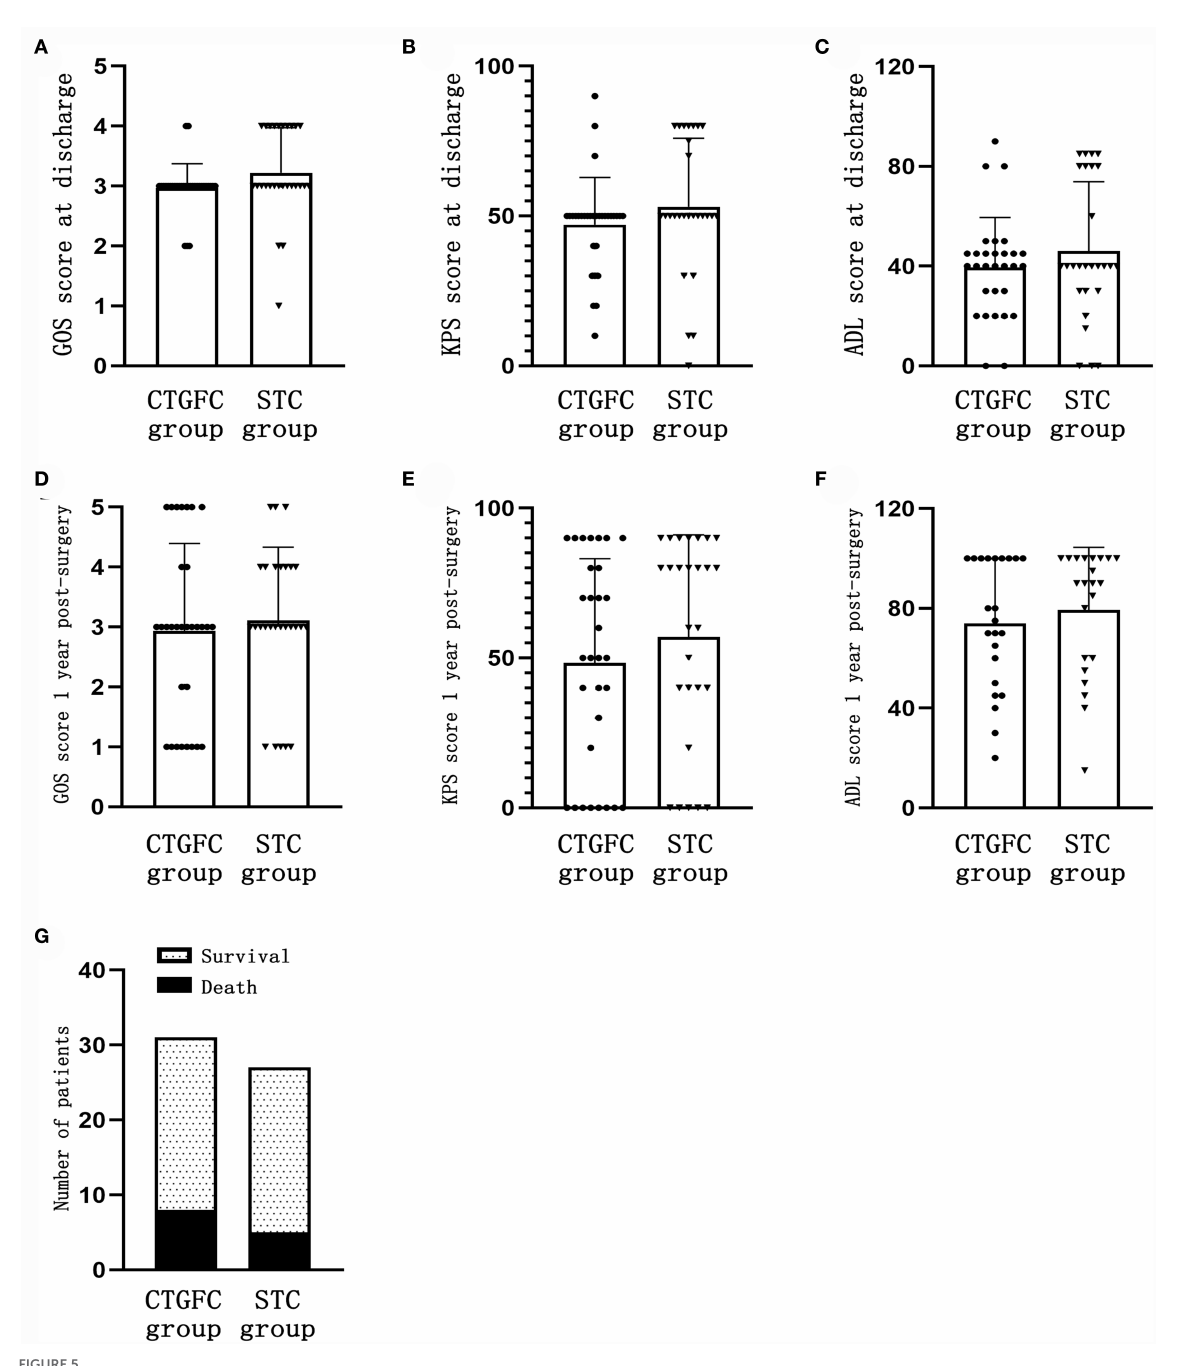
or neurological function before the planned STC